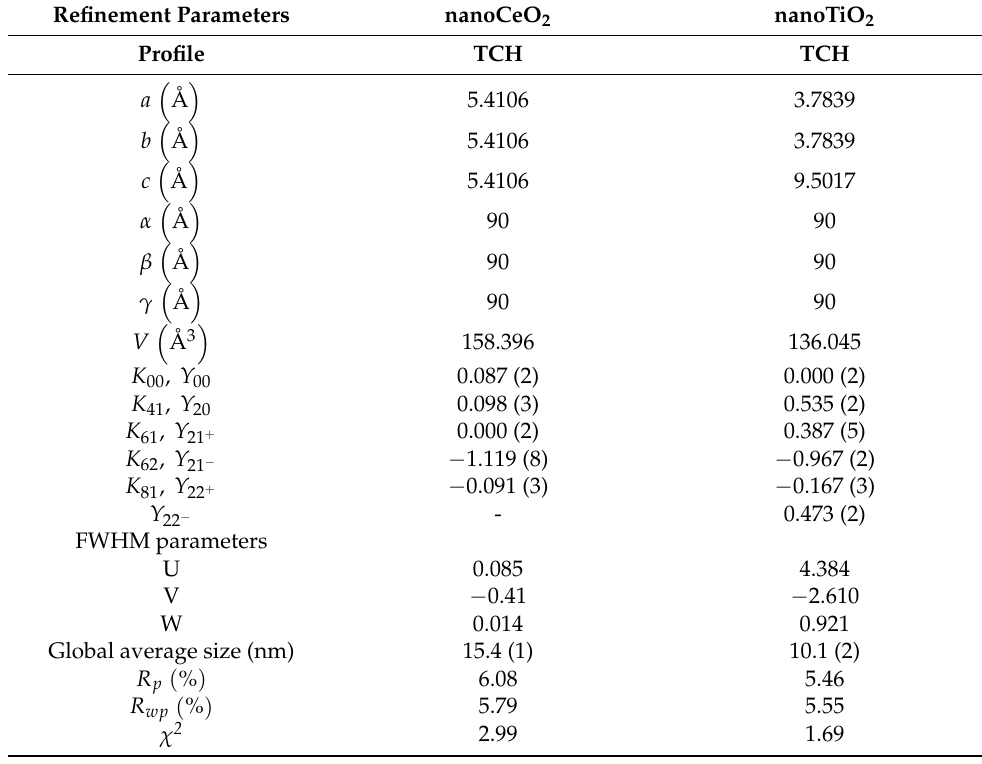
Table 2. Rietveld refinement parameters of CeO 2 and TiO 2 samples using the FullProf program: cell parameters, cell volume, and agreement factors. R p ( % ) and R wp ( % ) are the profile residual and the weighted profile residual factors, respectively, used to verify the Rietveld refinement quality. The goodness of fit, chi-square ( χ 2 ). The K coefficients correspond to the CeO 2 phase and the Y coefficients to the anatase